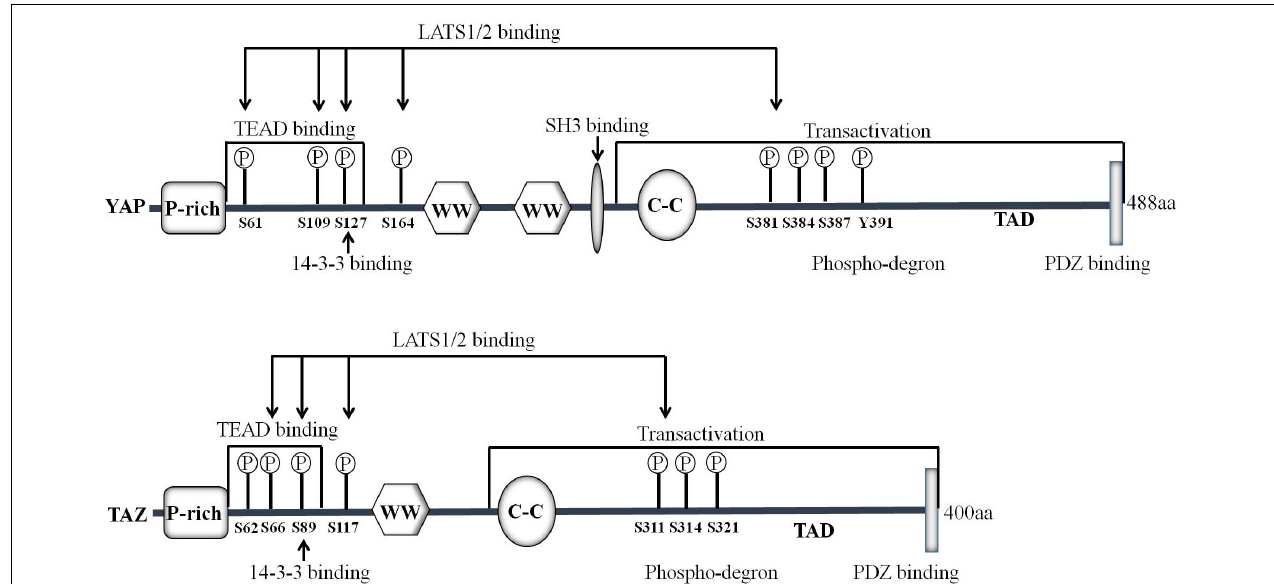
FIGURE 2 | Domain organization and key modifications of YAP/TAZ proteins. YAP is a proline-rich phosphoprotein mainly consisting of the SH3 binding domain, two WW domains and a highly conserved PDZ binding motif FLTWL at the C-terminus. TAZ is homologous to YAP and has only one WW domain. YAP/TAZ is phosphorylated by LATS1/2 on Ser 61 , Ser 109 , Ser 127 , Ser 164 , and Ser 381 (TAZ Ser 66 , Ser 89 , Ser 117 , and Ser 311 ) in the HxRxxS